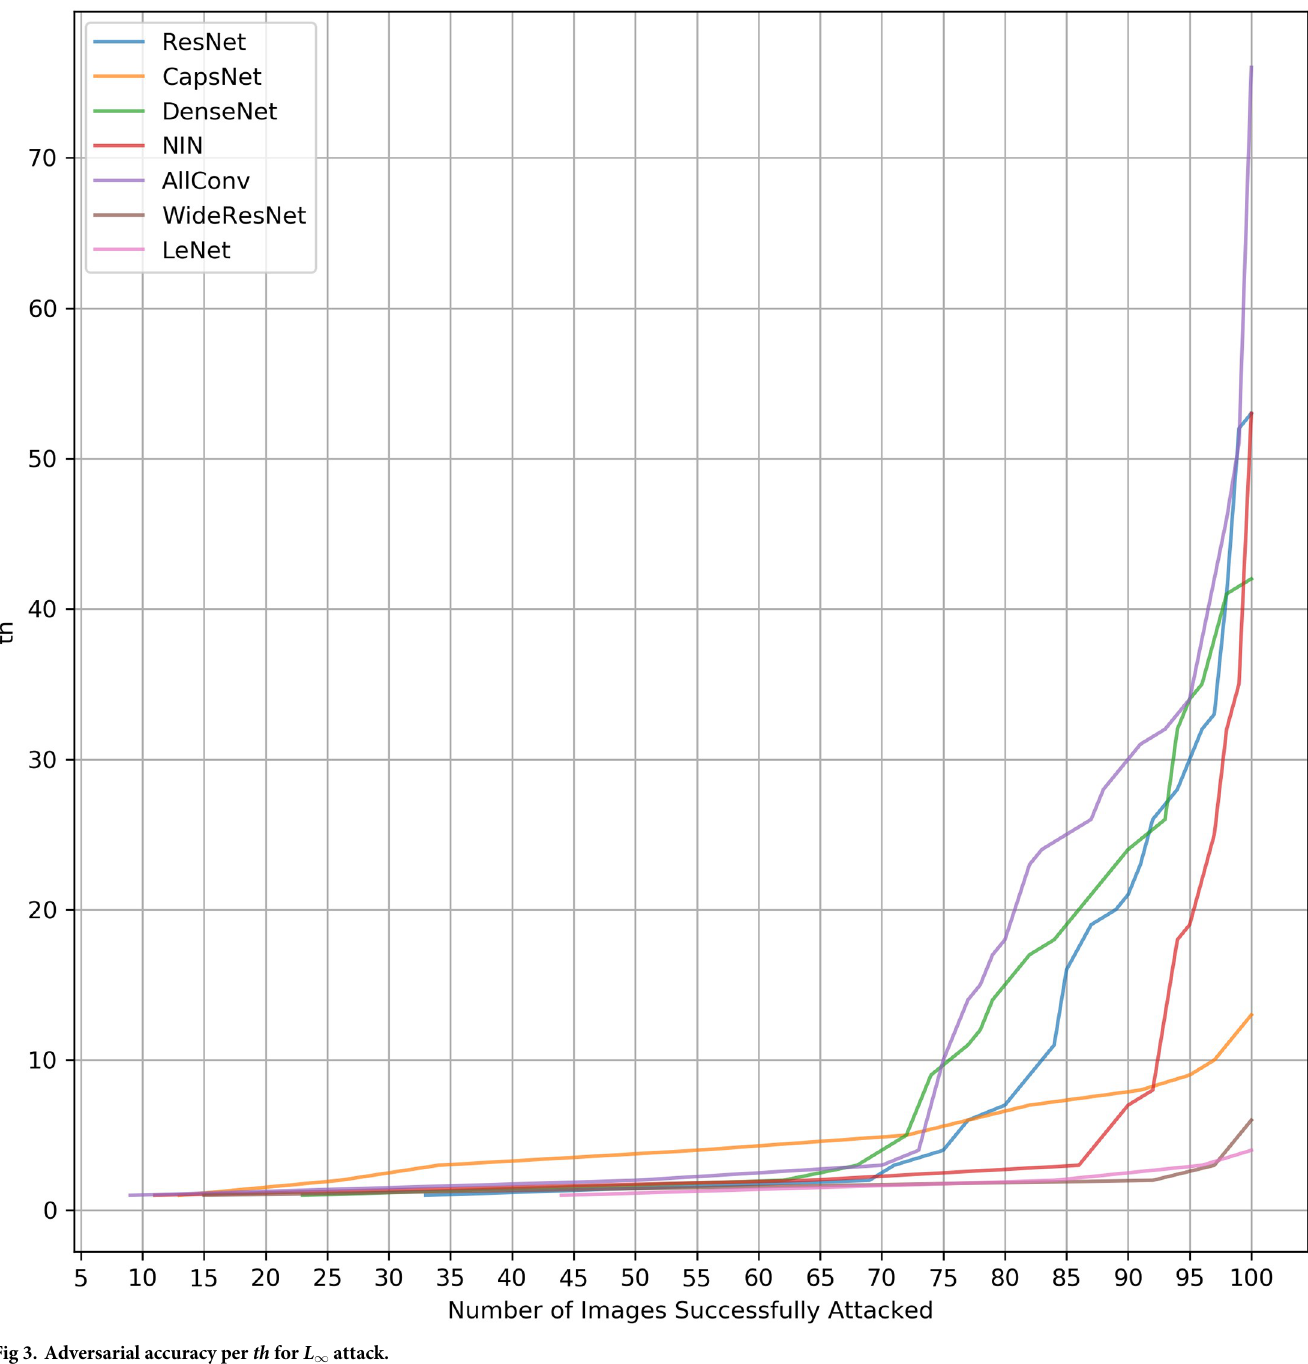
Fig 3. Adversarial accuracy per th for L 1